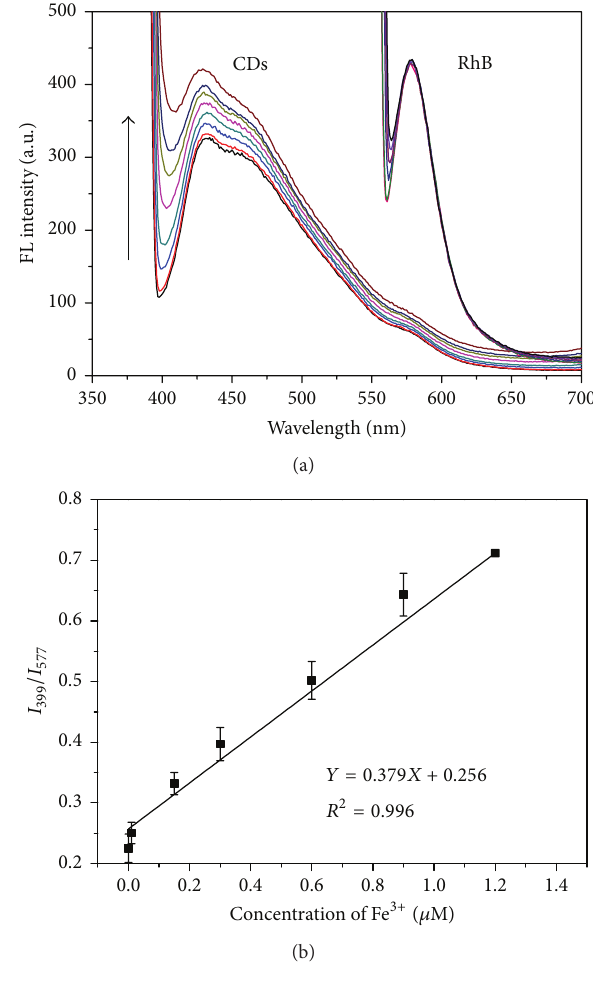
Figure 3: FT-IR spectra of the CDs. Figure 4: (a) FL emission spectra of the CD-RhB probe with different concentrations of Fe 3+ (from bottom to top, 0, 0.01, 0.15, 0.3, 0.6, 0.9, and 1.2 𝜇 M) in PB buffer solution (10mM, pH 7.4). (b) The 𝐼 399 /𝐼 577 ratios of the probe versus the concentration of Fe 3+ within the range of 0.01–1.2 𝜇 M. The error bars represent standard deviations based on three independent